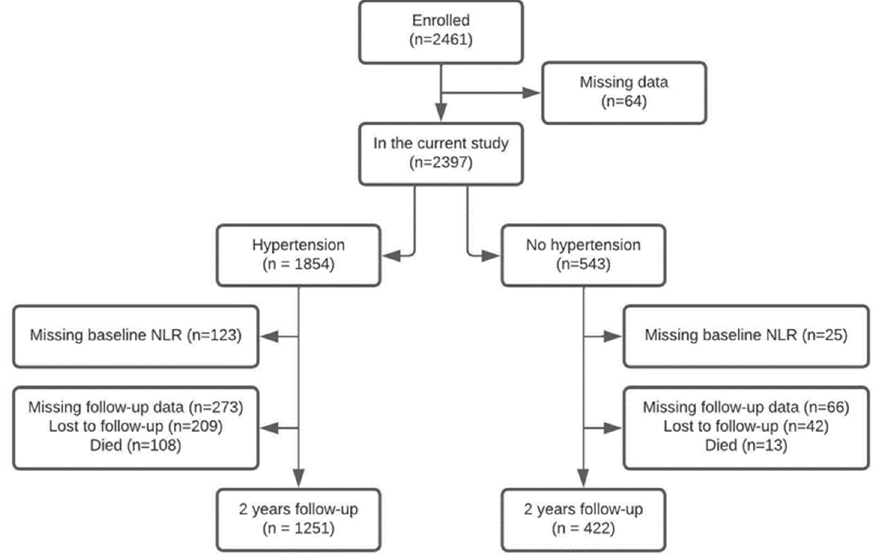
Figure 1. Flowchart on in- and exclusion of individuals within the current study.